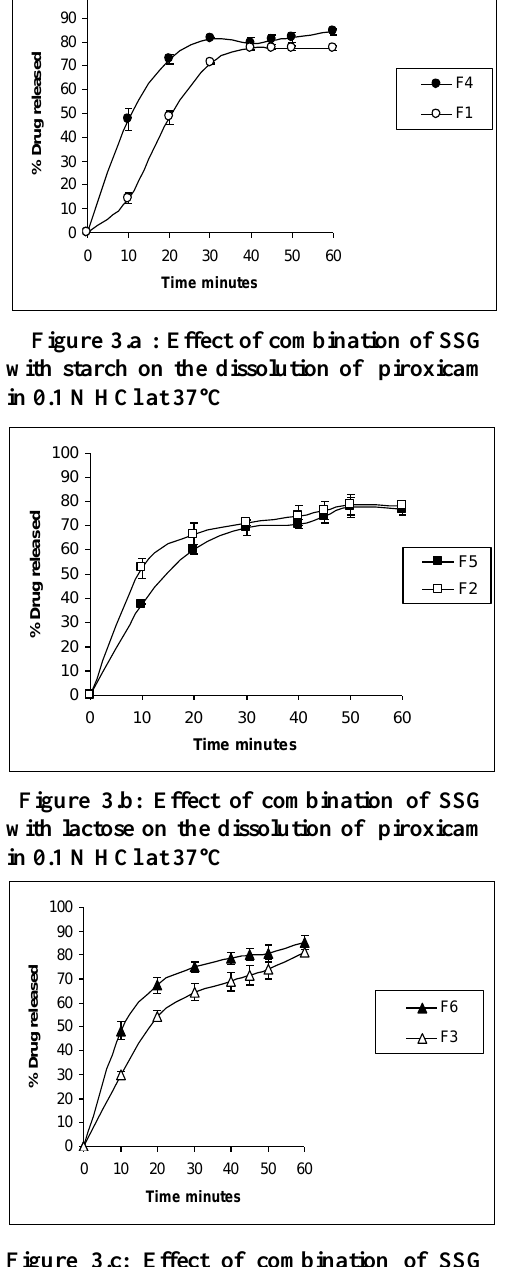
Figure 3.c: Effect of combination of SSG with lactose: starch (2:1) on the dissolution of piroxicam in 0.1 N HCl at